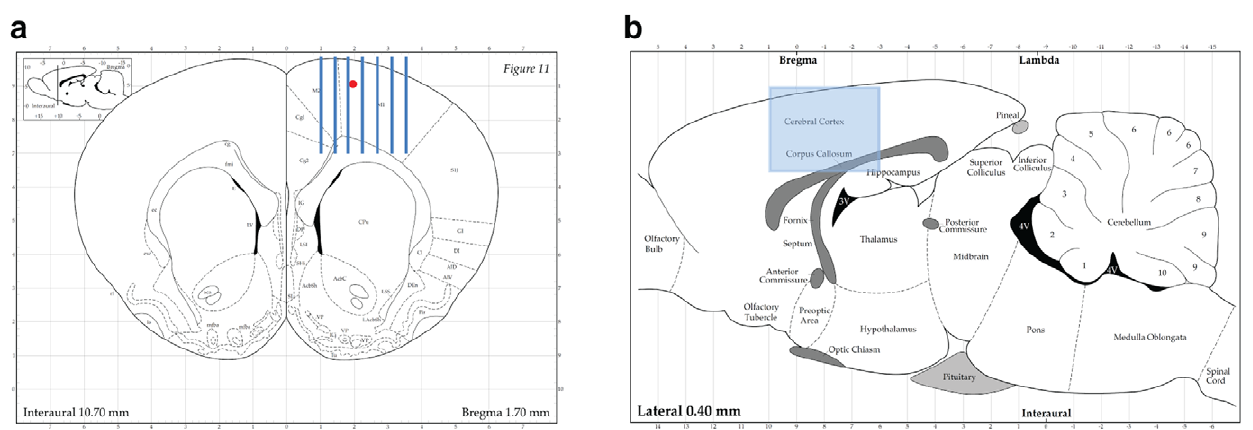
Figure 2. Schematic representation of microbeam irradiation geometry. Coronal (a) and sagittal (b) section of the Paxinos and Watson’s rat brain atlas. Arrays of 100 or 600 m m thick microbeams (here represented the 100 m m case, minimum center-to-center spacing: 400 m m) were delivered perpendicular to the sensorimotor cortex using an atlas-based image guided X-ray setup. In (a) is indicated the point where the kainic acid injection was performed to create status epilepticus in rats. Copyright 1998 with permission from Elsevier.